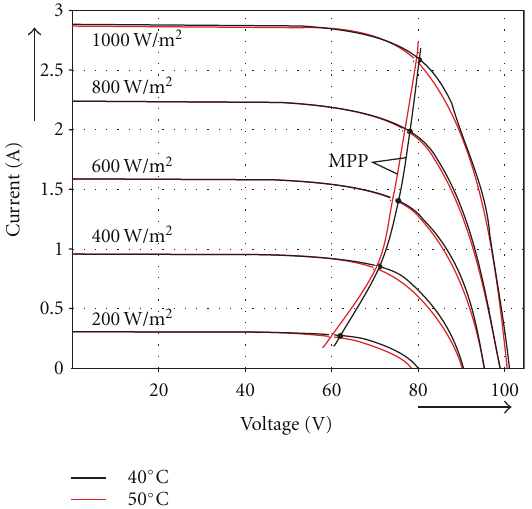
Figure 3: Changing of MPP with solar radiation and temperature.